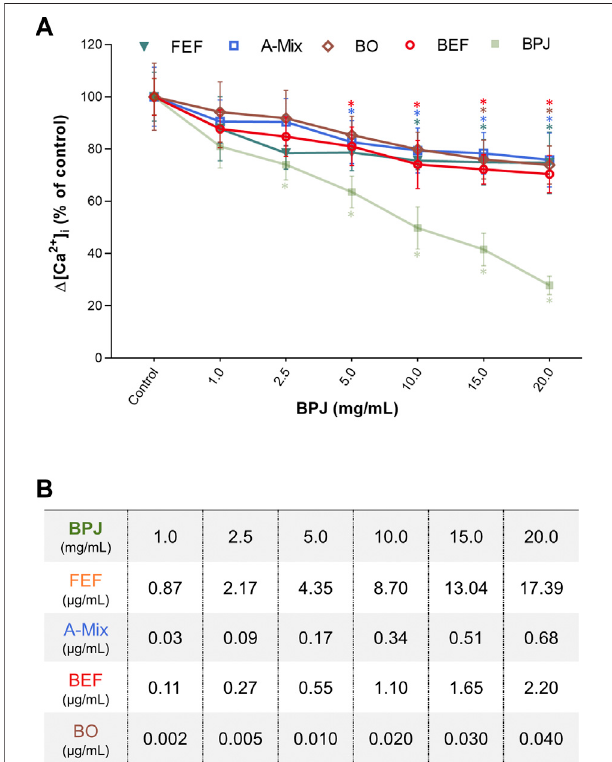
FIGURE 1 | Concentration-dependent effects of BPJ fractions/ compounds on the OT-induced increase of [Ca 2+ ] i . Myometrial hTERT-C3 cells were pre-treated with BPJ, FEF, A-Mix, BEF or BO prior to stimulation with 100 nM of OT (A) . Values represent the mean ± SEM of six independent experiments performed in quadruplicate and are expressed as percentageofcontrol;* p < 0.05.In (B) ,theconcentrationsofFEF,BEF,A-Mix and BO corresponding to the BPJ concentrations are